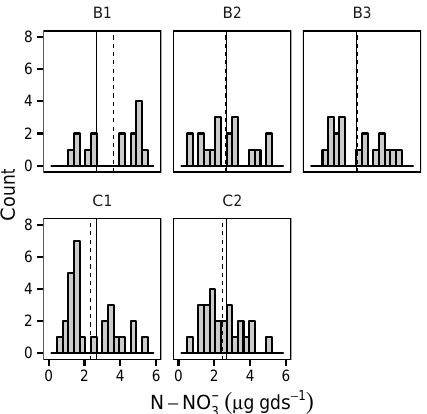
and NO − ; d ) prior 4 3